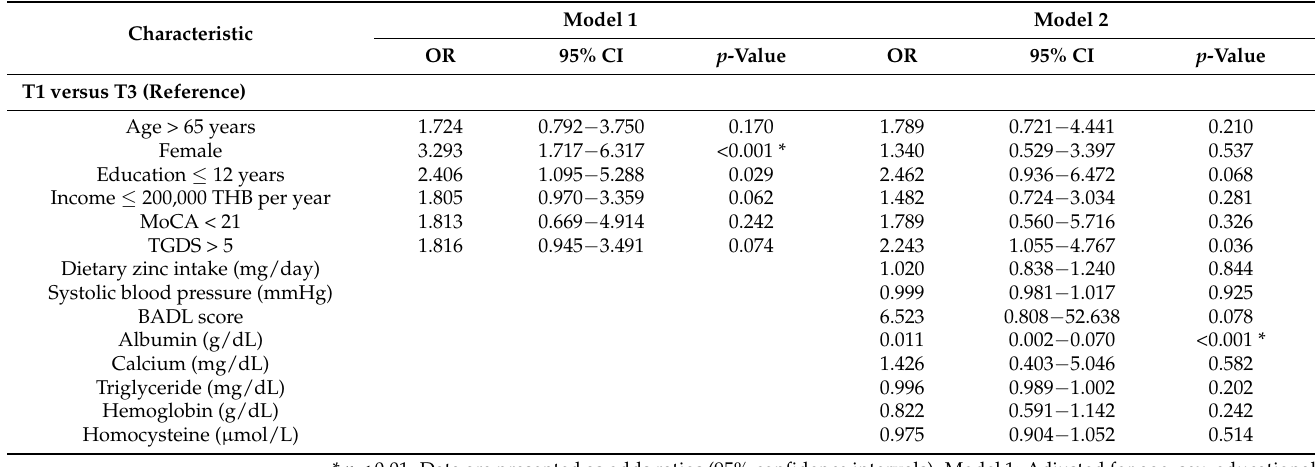
Table 4. Multivariate multinomial logistic regression analysis results (serum zinc levels in T1 vs. T3).